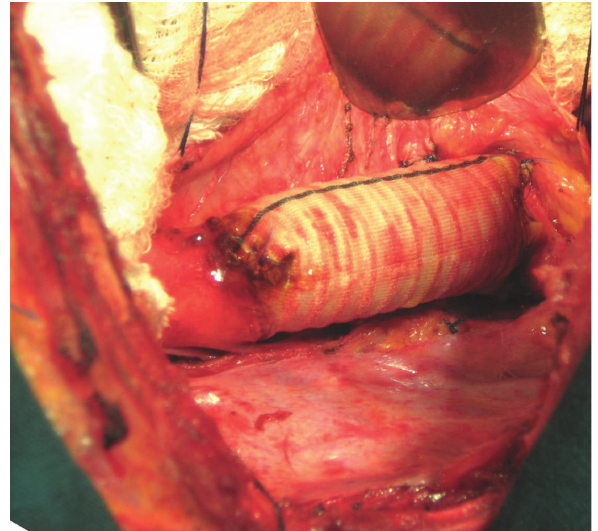
Fig. 3 - CoAo corrigida com tubo de Dacron.